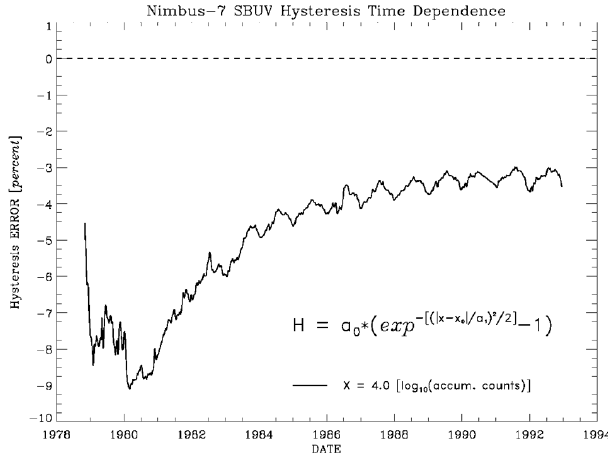
Fig. 14. Time dependence of the Nimbus-7 SBUV hysteresis correc- tion for a signal level of 10000 accumulated counts. The functional form used to parameterize the hysteresis correction is also shown.